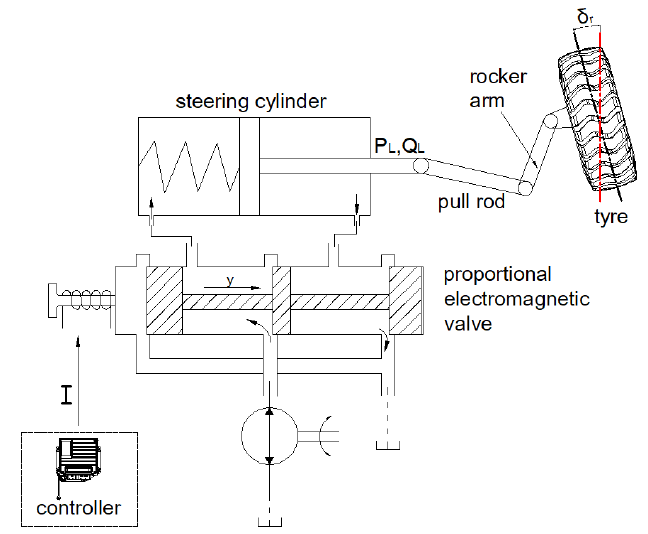
Figure 5. The schematic diagram of the rear wheel steering system.